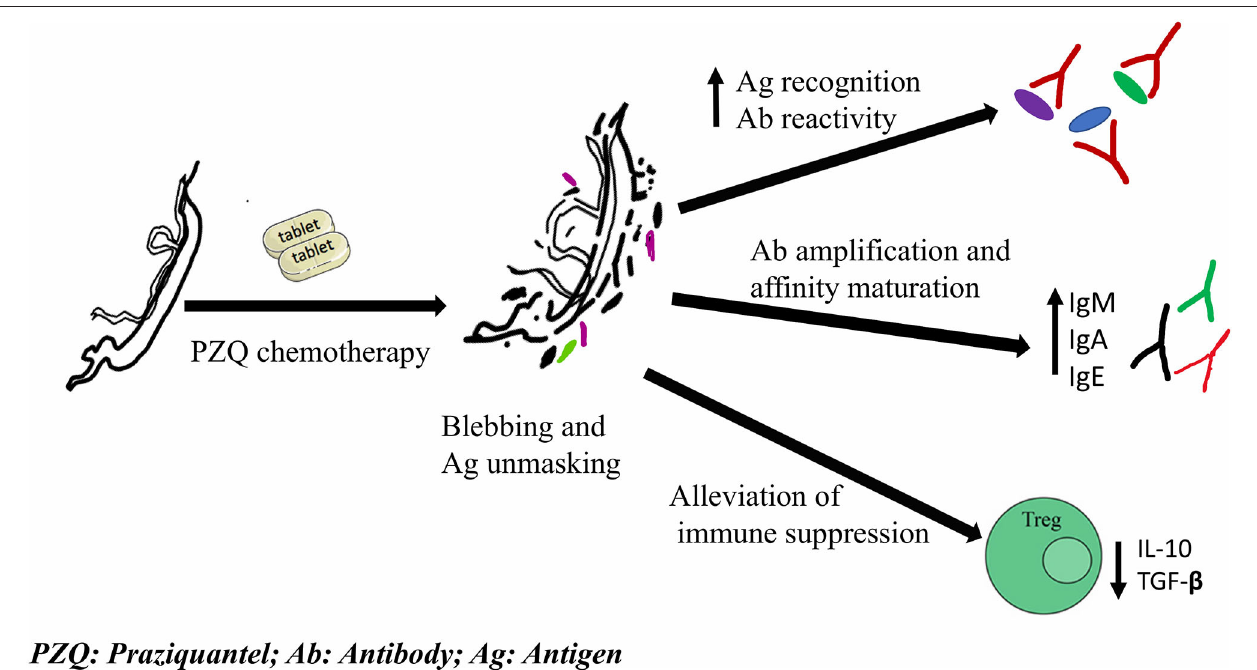
FIGURE 1 | Schematic summary of PZQ-induced immune-modulatory responses that potentially impact vaccine response upon co-administration/delivery. PZQ acts on parasite tegument causing vacuolation and blebbing. This unmasks worm antigens and elicits an increased antigen recognition, antibody reactivity, amplification and affinity maturation, and alleviates the immune suppression induced by live